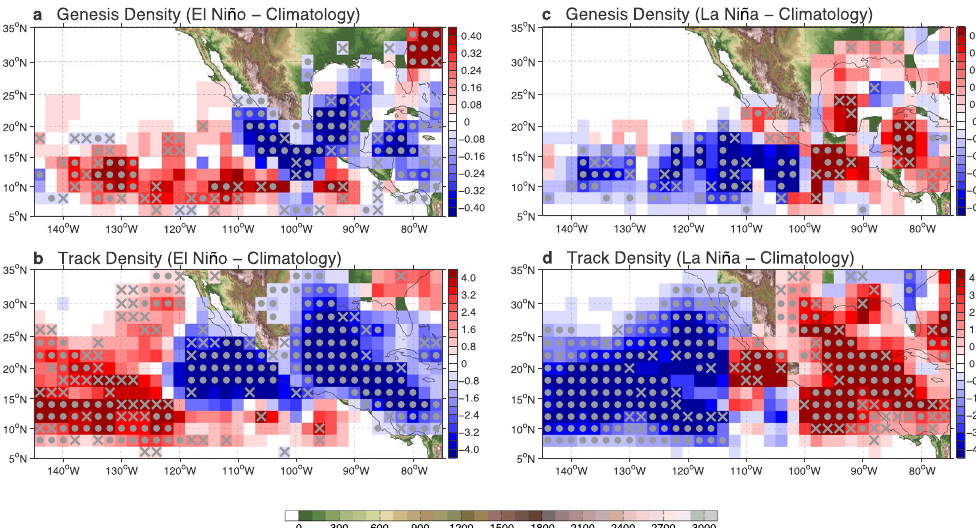
Figure 1. ENP TC variability during El Niño and La Niña. The El Niño hurricane seasons composite minus climatology difference in ( a ) TC genesis density (unit: TCs per 10 seasons), and ( b ) TC track density (unit: TCs per 10 seasons). ( c ), ( d ) are same as ( a ), ( b ) but for the difference from the La Niña hurricane seasons composite minus climatology. Gray dots (crosses) denote statistical confidence at the 95% (90%) level. Statistical significance test is performed based on the two-sample t-test. Land topography (unit: m) is shaded green- brown. The maps were generated using M_Map V1.4 package for Matlab (http://www.eos.ubc.ca/~rich/map.